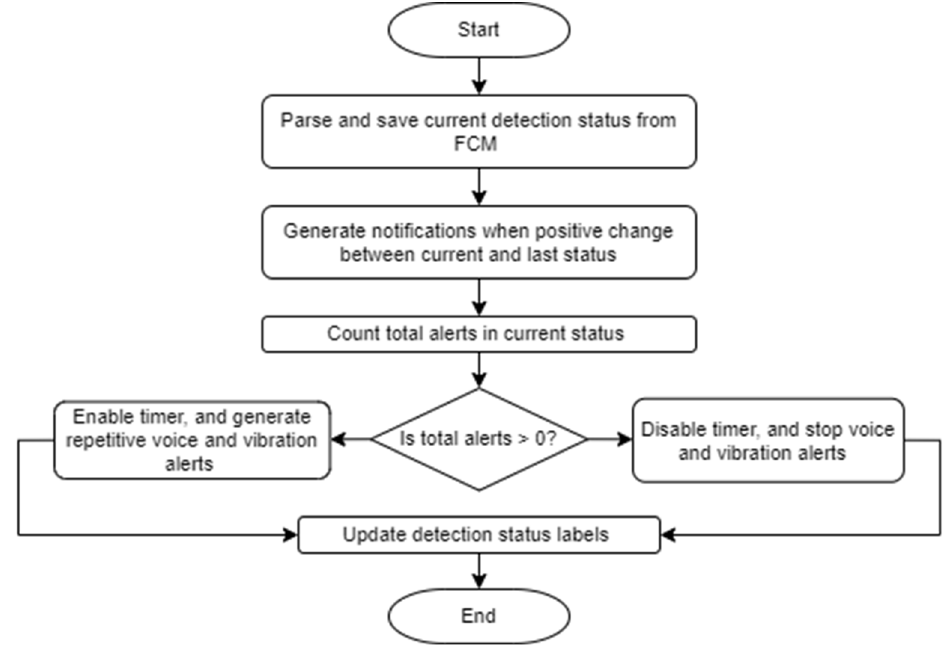
Figure 8. Alert generation after FCM message arrives.